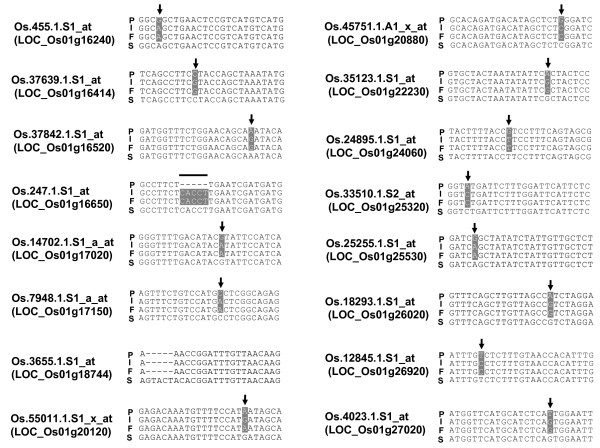
Alignments of SFPs in the Saltol region. Polymorphic residues are highlighted in gray. The locus corresponding to each probe set is indicated in parentheses. Arrows indicate SNPs. Bar, INDEL. P, Pokkali; I, IR29; F, FL478; S, target sequence from SIF.